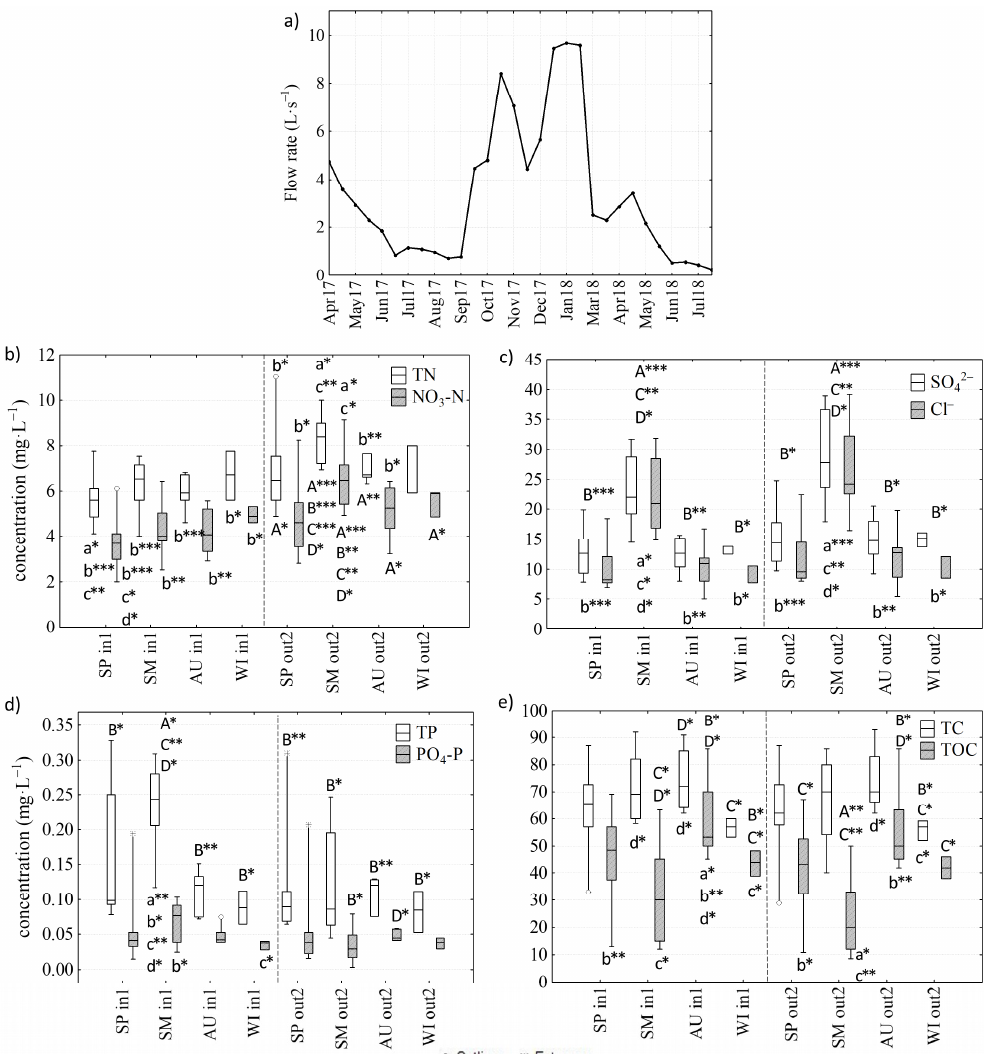
Figure 3. ( a ) Flow rate (L · s − 1 ) changes in the study period. Inlet (in1) and outlet (out2) concentrations of ( b ) total nitrogen (TN) and nitrate (NO 3 -N), ( c ) sulphate (SO 42− ) and chlorine (Cl − ), ( d ) phosphate (PO 4 -P) and total phosphorus (TP), ( e ) total carbon (TC) and total organic carbon (TOC) in spring (SP), summer (SM), autumn (AU) and winter (WI). Median, min/max and 25% and 75% quartile values are presented. Asterisks with letters indicate statistically significant differences between seasonal inlet and outlet concentrations, according to the Mann-Whitney U test: *** p < 0.001, ** p < 0.01, * p < 0.05. Capital letters indicate significant seasonal differences ( p < 0.05) for left-side boxes; small letters show differences for right-side